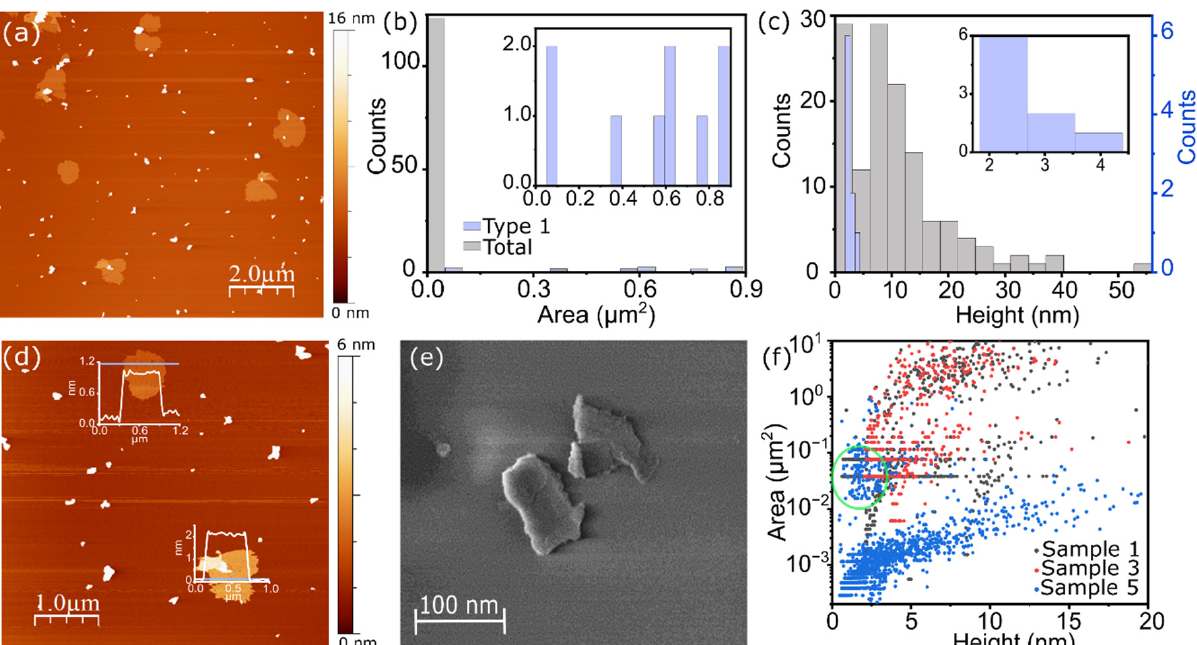
Figure 3. AFM study of LPE cylindrite flakes. ( a ) AFM topographic characterization of cylindrite nanoflakes obtained in Sample 5. Image dimension: 10 × 10 µm 2 . Statistical analysis of AFM ( b ) area and ( c ) height of cylindrite nanoflakes. The inset graphics show the distribution of type 1 flakes in each case. ( d ) AFM topographic characterization of cylindrite nanoflakes with the corresponding height profile of two type 1 flakes. Image dimension: 5 × 5 µm 2 . ( e ) SEM image of the cylindrite nanosheets obtained in Sample 5. ( f ) Scatter plot of area and height data of Sample 1 (gray), Sample 3 (red), and Sample 5 (blue) LPE cylindrite nanosheets obtained through an AFM study.